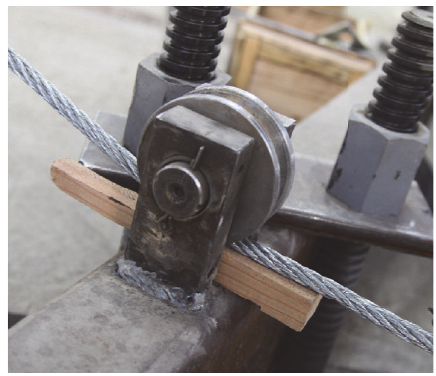
Figure 5: Fixed device.